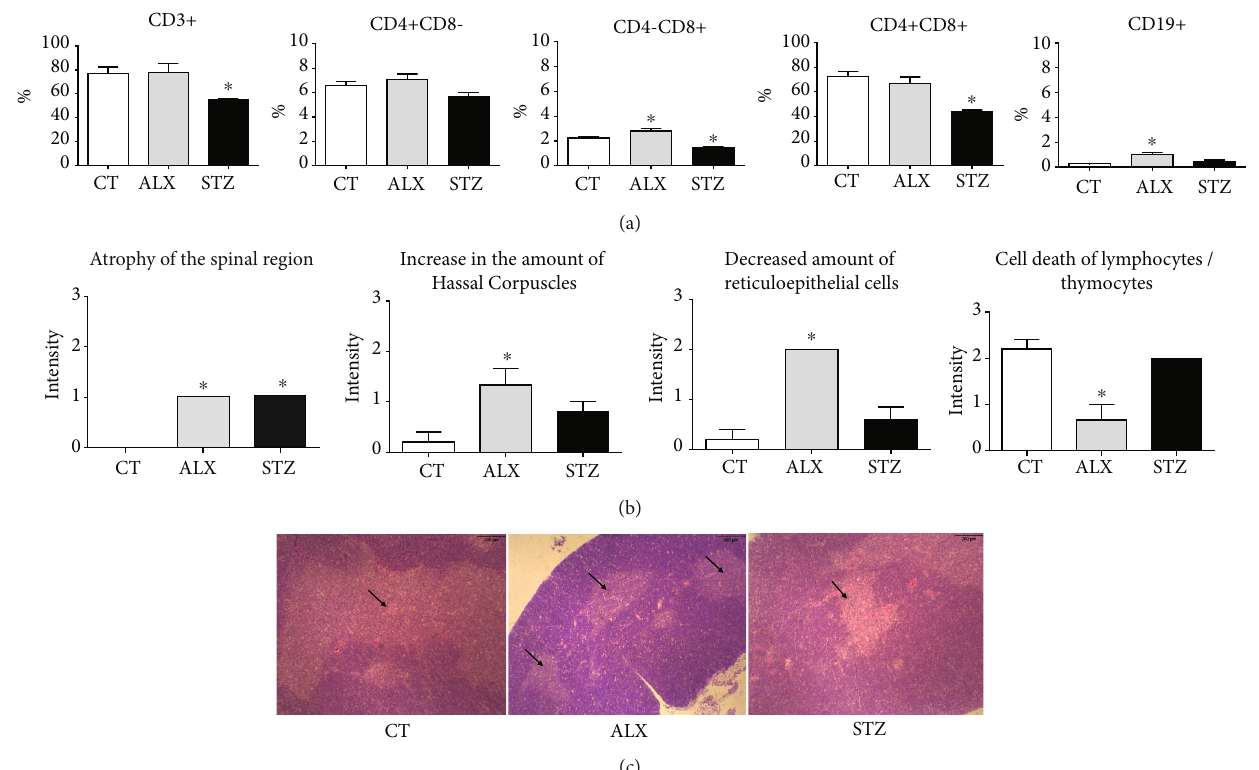
Figure 4: Short-term diabetogenic e ff ects of ALX and STZ on the thymus. T1D was induced as described in Methods, and (a) thymuses from the CT, ALX, and STZ groups were collected on the 15 th day and characterized according to the percentage of CD3 + , CD4 + CD8 - , CD4 - CD8 + , CD4 + CD8 + , T lymphocytes, and CD19 + B lymphocytes. (b) Evaluation of structural changes in the thymus. (c) Representative microphotographs of 3 μ m sections of thymus tissue stained with H&E (scale 200 μ m). The arrows indicate atrophy of the spinal region in diabetic animals induced with ALX or STZ. Data are presented as mean ± SEM , ∗ p ≤ 0 : 05 (6-13 animals per